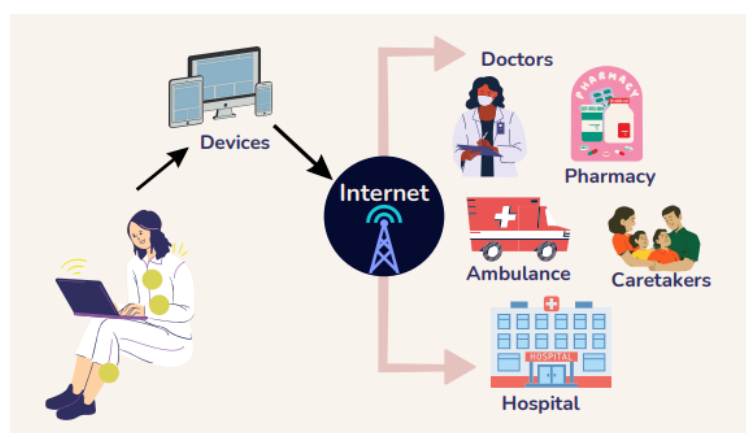
Figure 3. A real-time telemedicine infrastructure.